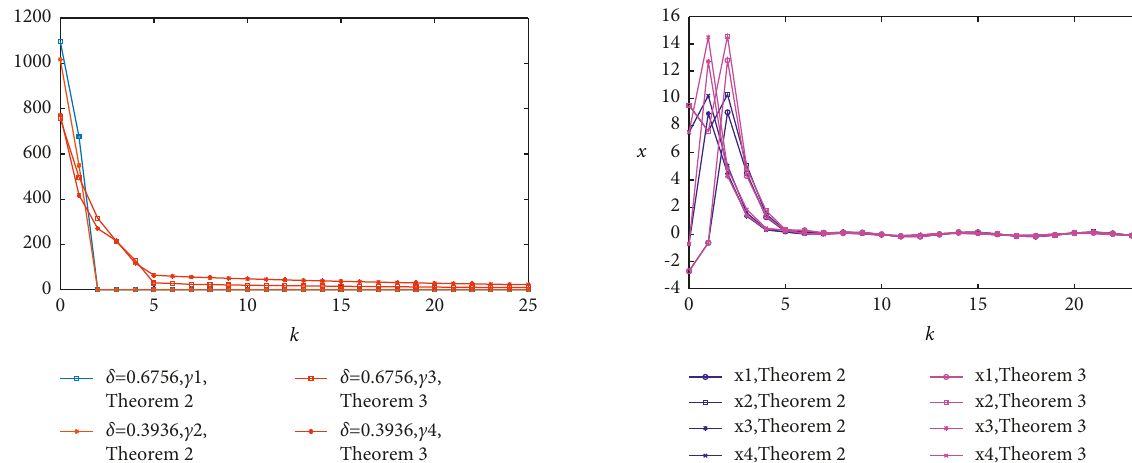
Figure 19: State trajectory with δ � 0 .